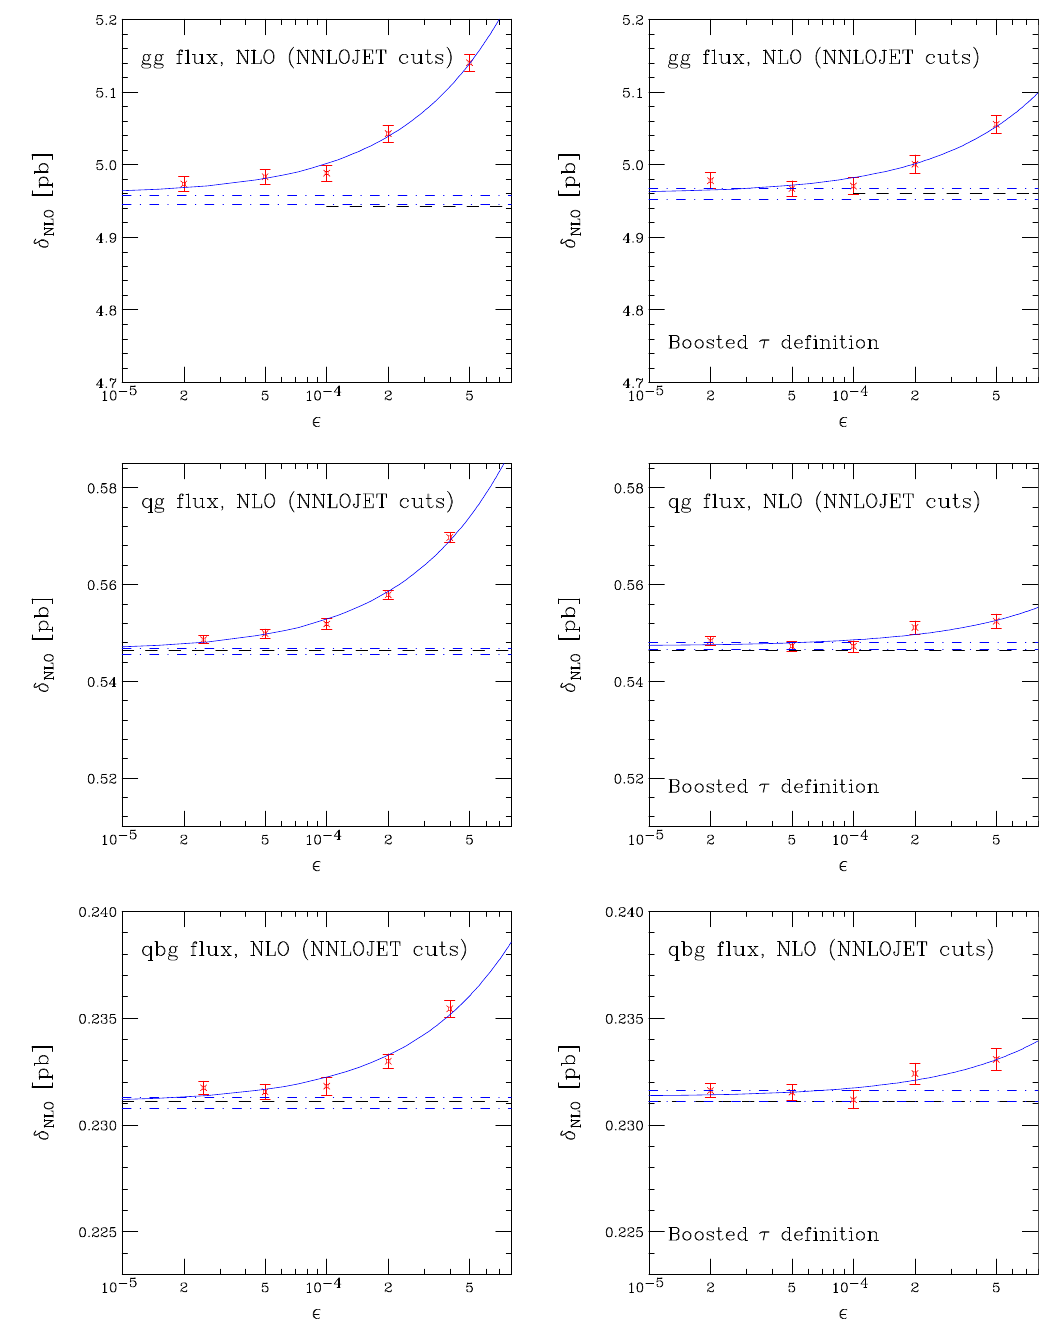
Figure 2 . (cid:28) -dependence of NLO coe(cid:14)cients for the gg , qg and (cid:22) qg partonic channels, in the NNLOJET setup. The plots on the left show the result when T 1 is computed in the hadronic c.o.m. and the ones on the right indicate the corresponding result when evaluating this quantity in the boosted frame. The (blue) solid lines correspond to the (cid:12)t form in eq. (3.4), with the dot-dashed lines representing the errors on the asymptotic value of the (cid:12)t. The exact results, computed in MCFM using dipole subtraction, are shown as the black dashed lines.